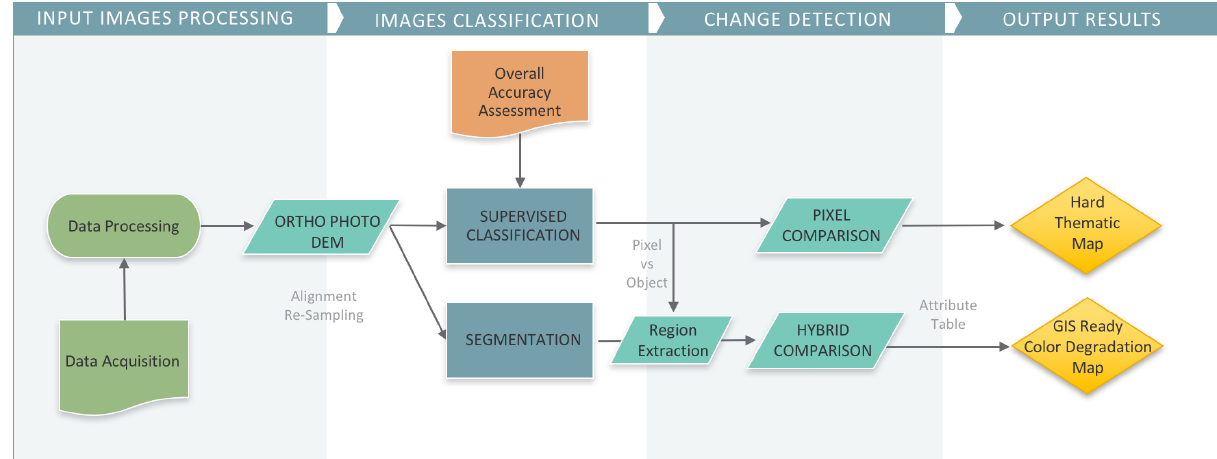
Figure 3. General workflow performed to achieve change detection information about the bas-relieves analysed different ´epoques; these pixels comprise the change mask.